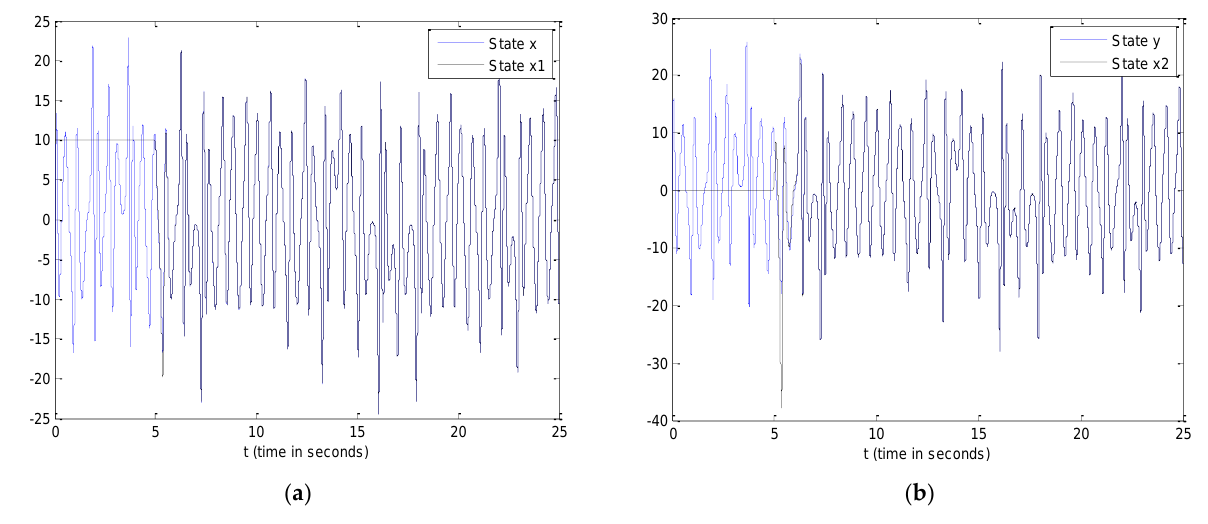
Figure 6. Fractional order derivative with 𝛼 = 0.9,0.8,and 0.5 and time delay 𝜏 = 5 s. The phase por- traits for the time-delay synchronization between Chen ( Black Line) and Lorenz Chaotic systems (Blue Line): ( a ) On (𝑥 − 𝑦,𝑥 1 − 𝑥 2 ) phase plane; ( b ) on (𝑥 − 𝑧,𝑥 1 − 𝑥 3 ) phase plane; ( c ) on (𝑦 − 𝑧,𝑥 2 − 𝑥 3 ) phase plane; ( d ) on (𝑥 − 𝑦 − 𝑧,𝑥 1 − 𝑥 2 − 𝑥 3 ) space. Figure 7 shows the time response plots of time-delay synchronized states of the mas- ter and slave systems with 𝛼 = 0.9 , and in Figure 8, they are shown with 𝛼 = 0.9, 𝛼 = 0.8, and 𝛼 = 0.5.